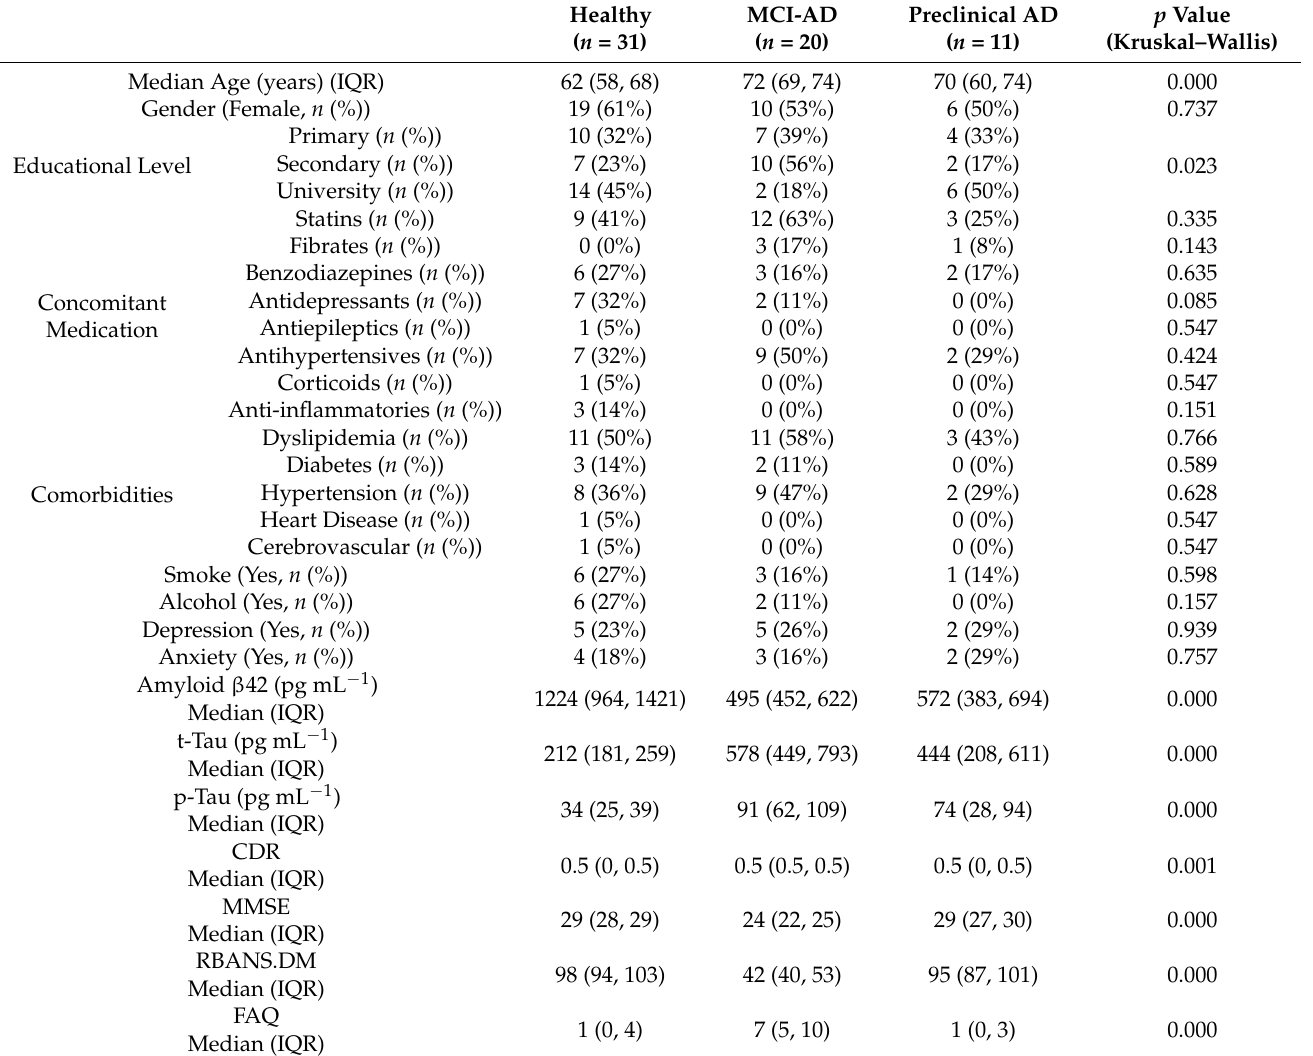
Table 2. Clinical and demographic participant